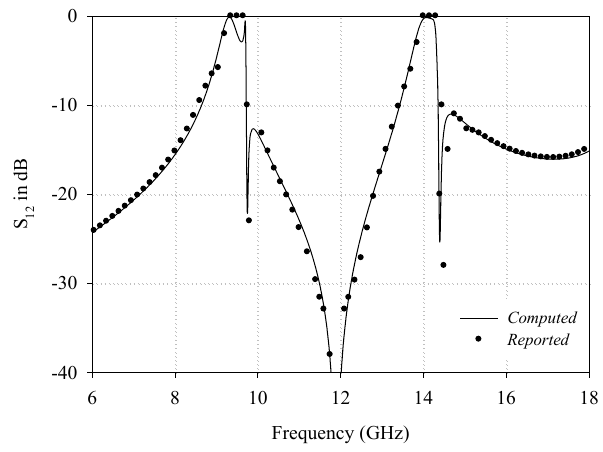
Figure 8. Transmission coefficient of SIW–cavity using Double Square loop FSSs. Solid line show computed result at dept. of ECE, NITT. Bubbles show reported results from figure 2 in [27].